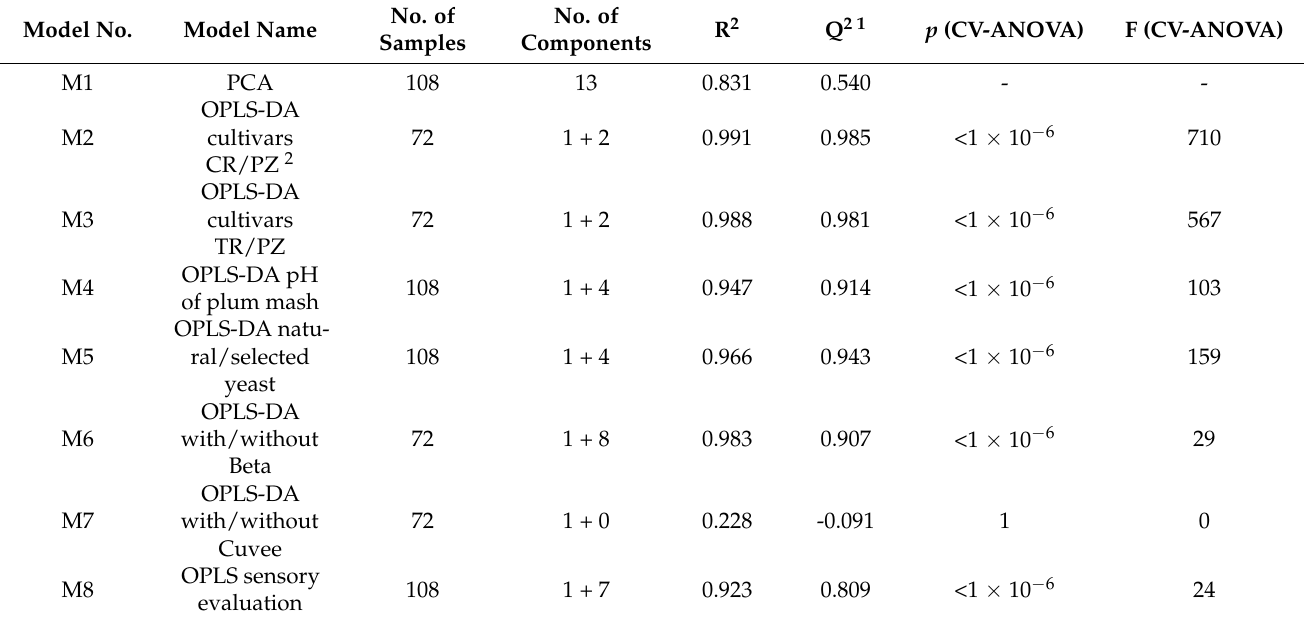
Table 1. Parameters of the multivariate analysis